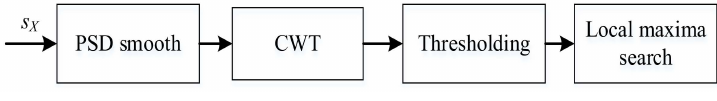
Figure 2. Schematic of Modified CWT Detection.